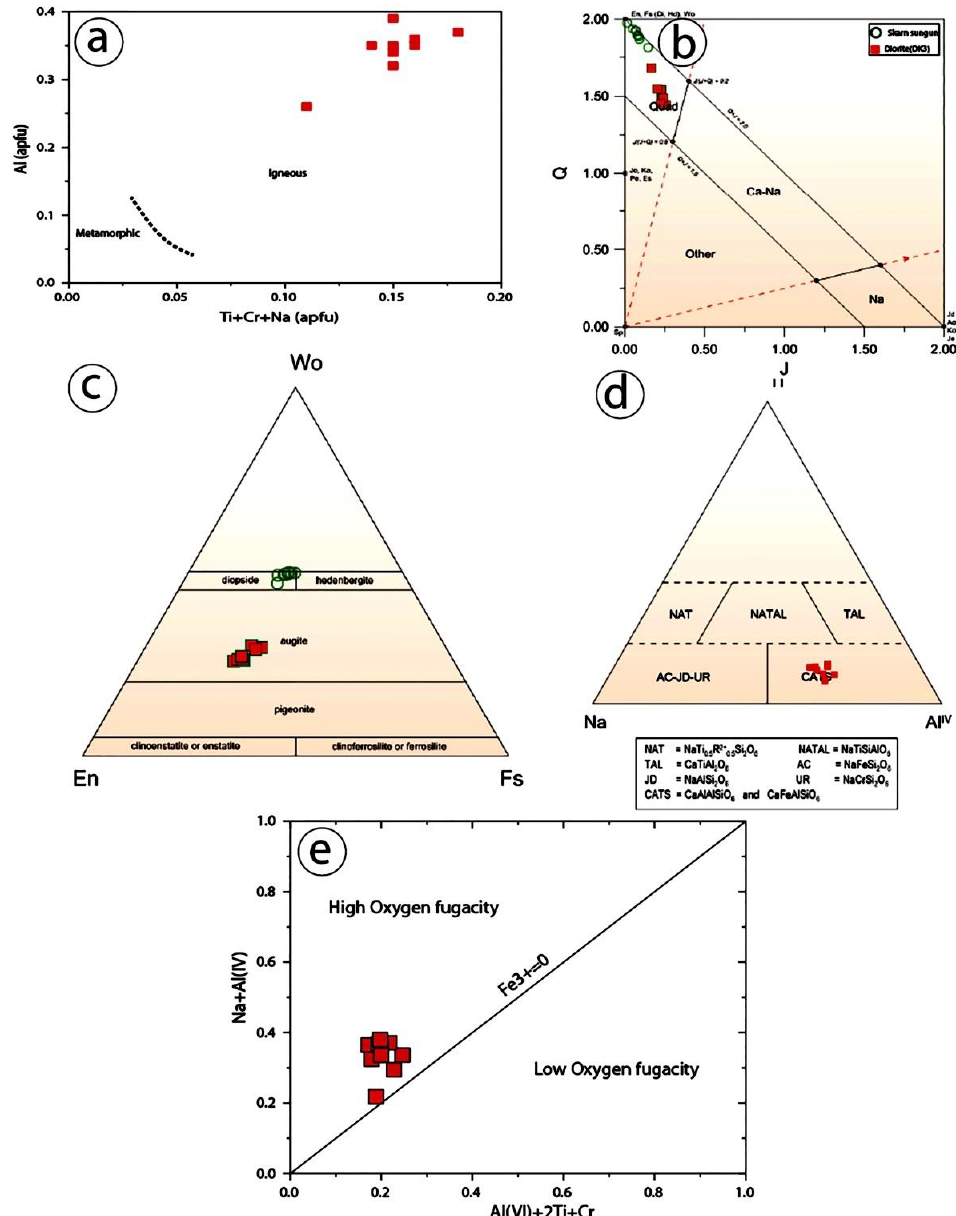
Figure 9. ( a ) Al diagram vs. Ti-Na- Cr to distinguish igneous from metamorphic pyroxene; all clinopyroxenes are located in igneous field [29]. ( b ) The Q-J clinopyroxene classification diagram [27]. ( c ) Wo-En-Fs ternary diagrams of pyroxene [27]. ( d ) Clinopyroxene ternary diagram of Ti-Na- Al IV , studied samples are located exclusively in the CATS field. (e) An estimation of oxygen fugacity from pyroxene compositions in diorite dykes [32].